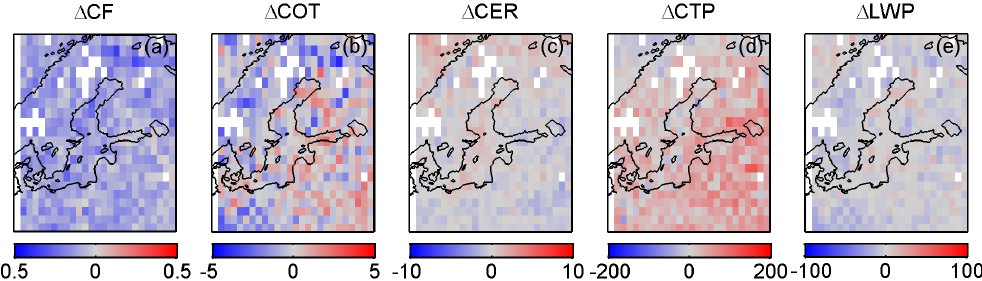
Figure 6. Spatial distributions of the difference of the cloud properties CF (a) , COT (b) , CER (c) , CTP (d) , and LWP (e) for low aerosol loading (AOD<25th percentile) and heavy aerosol loading (AOD>75th percentile) calculated from Eq.